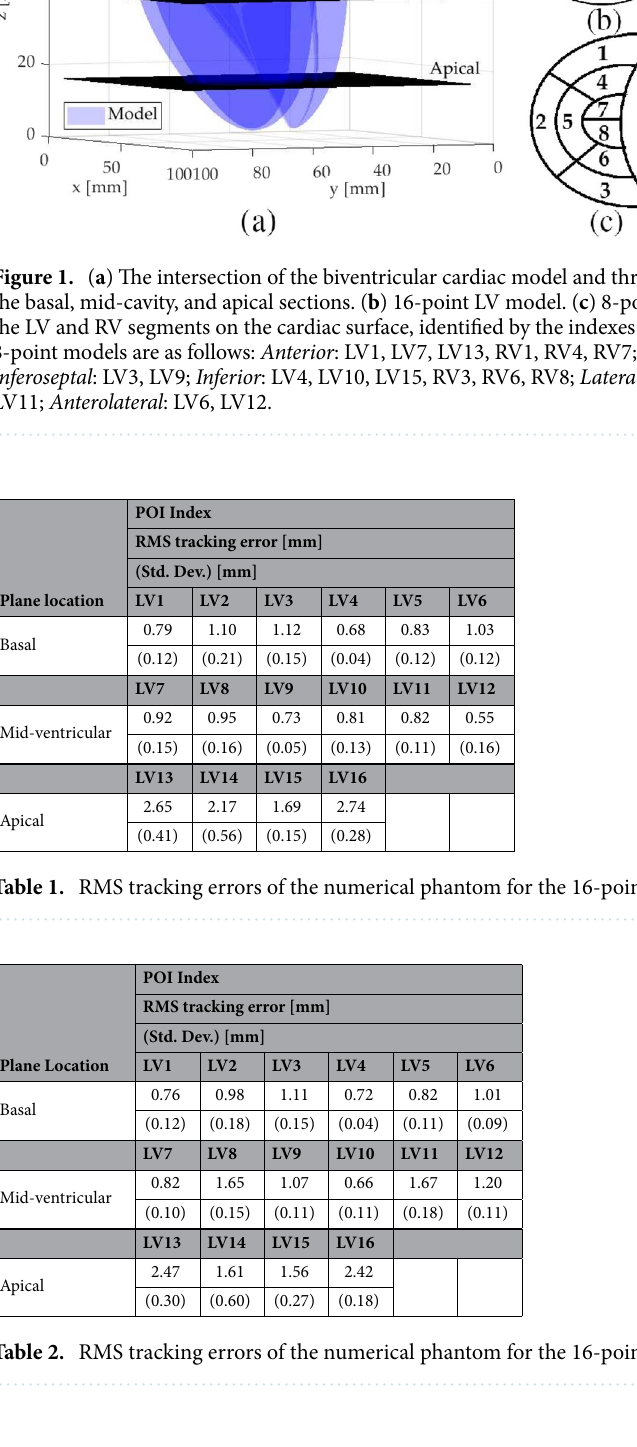
The results show that with the fixed slice plane, the tracking errors are within 3 pixels (5.3 mm). The RMS errors are respectively 2.30 mm for the POIs on LV and 2.77 mm for the POIs on RV. The overall RMS error is